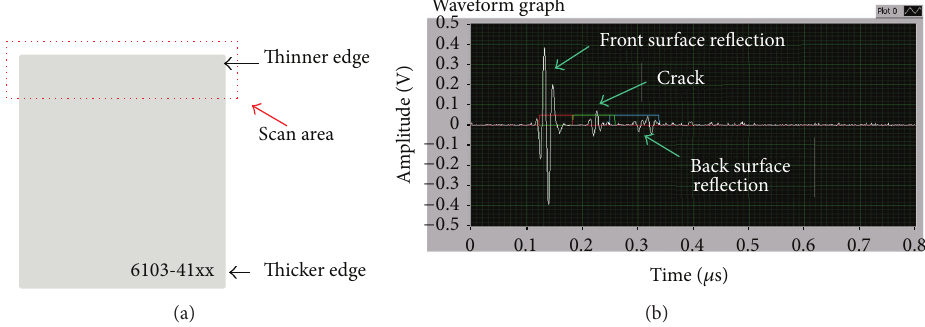
Figure 6: (a) Scanning area by acoustic microscopy; (b) a typical waveform of scanning point at a cracking